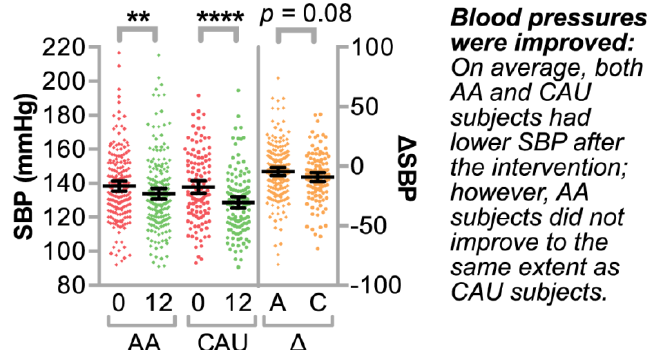
Figure 2. Systolic blood pressures of participants enrolled in hypertension intervention. The systolic blood pressures (SBP, left y -axis) of African American (AA, A, n = 193) or Caucasian (CAU, C, n = 123) participants in the hypertension intervention at the start of the intervention (0) and after 12 months of the intervention as well as the change in SBP (Δ, right y -axis) after 12 months are represented by a dot plot and summarized by mean ±95% confidence intervals: **** p < 0.0001 and ** p < 0.01 via the paired t -test of SBP. The p value of the unpaired t -test comparing the ∆ of AA versus CAU cohorts is also indicated.